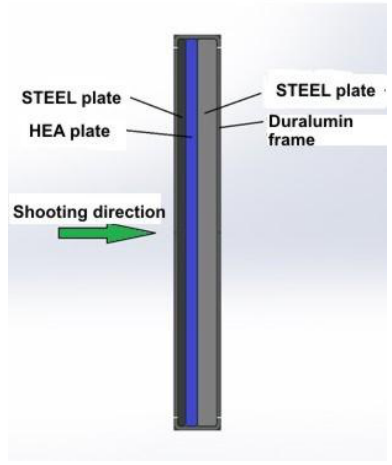
Figure 11. The shooting scheme for structure 4.